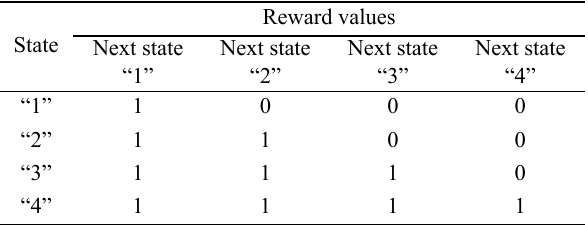
Table 8 New reward values of different actions in different states. State